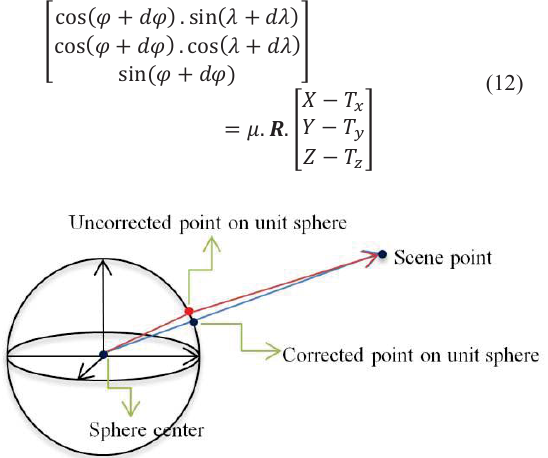
Figure 4. Ideal line (blue) where three points lie on the same line versus uncalibrated situation